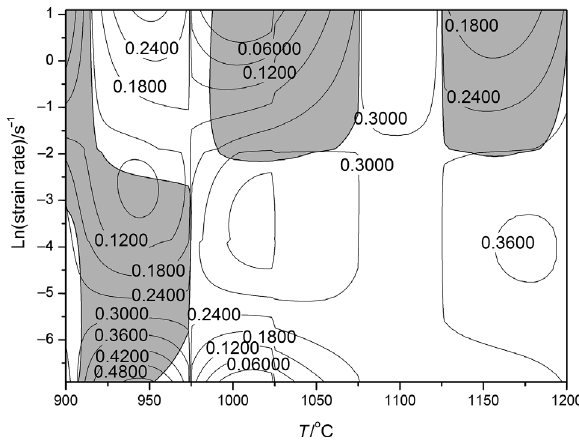
Figure 4: Power dissipation and rheological instability when the strain is